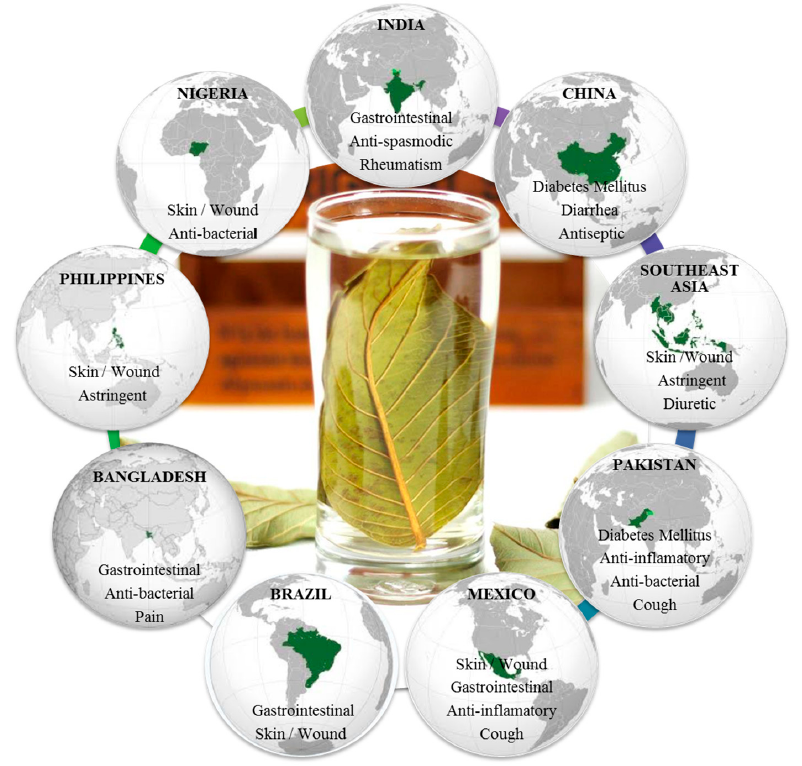
Figure 1. Main traditional uses of guava leaves in the principal producer countries.